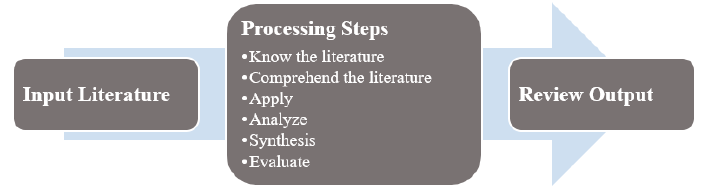
Figure 2. Three stages of effective literature review process, adapted from Levy and Ellis [31].